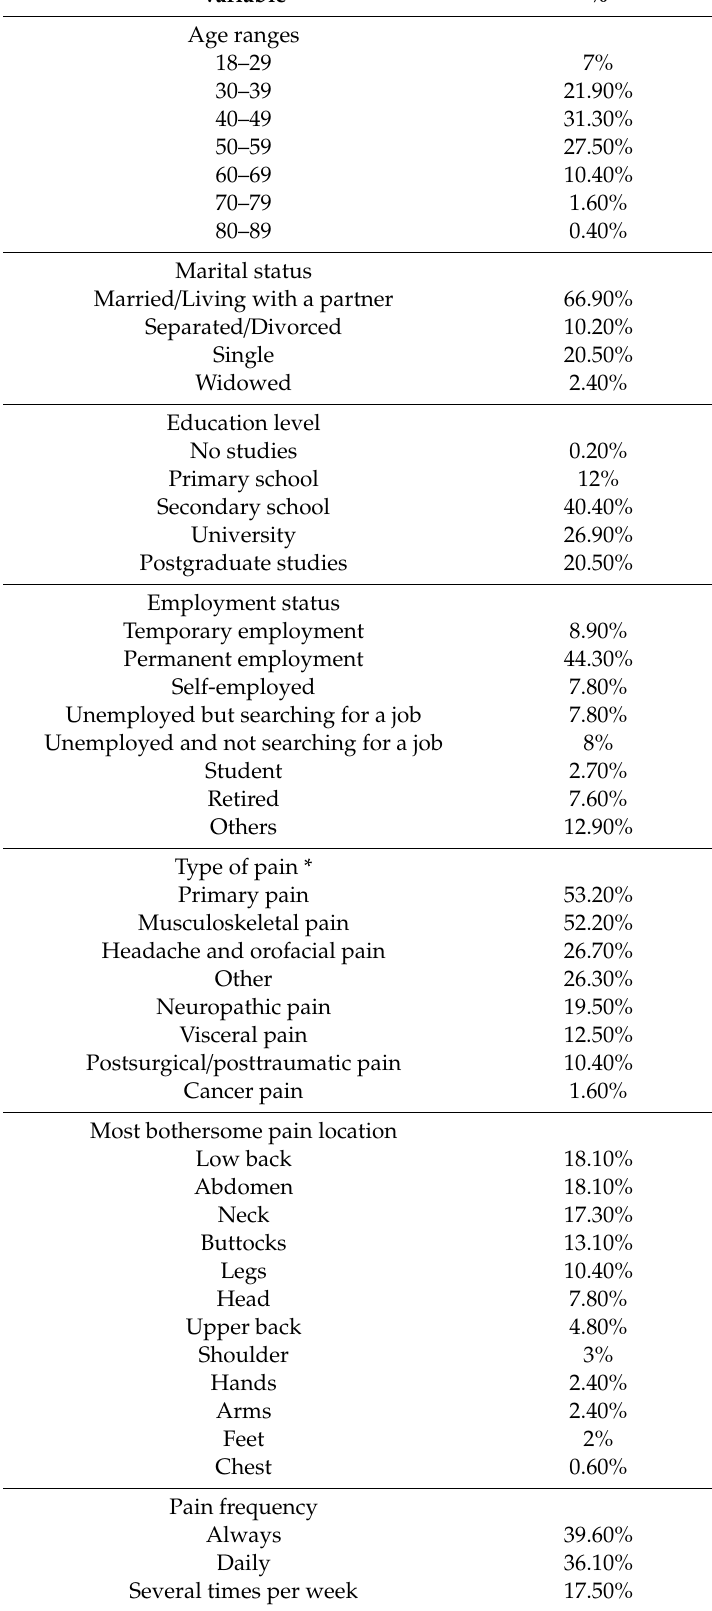
Table 1. Sociodemographic and pain characteristics of the study